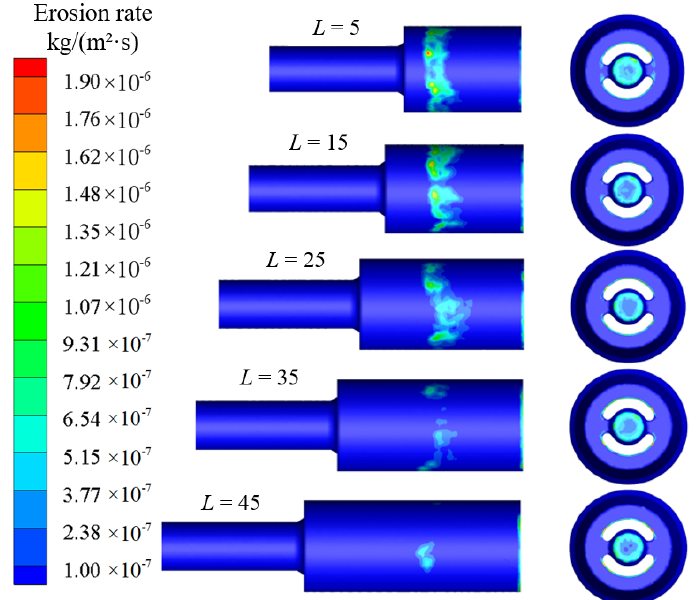
Figure 16. Erosion area changes with plug transition distance.